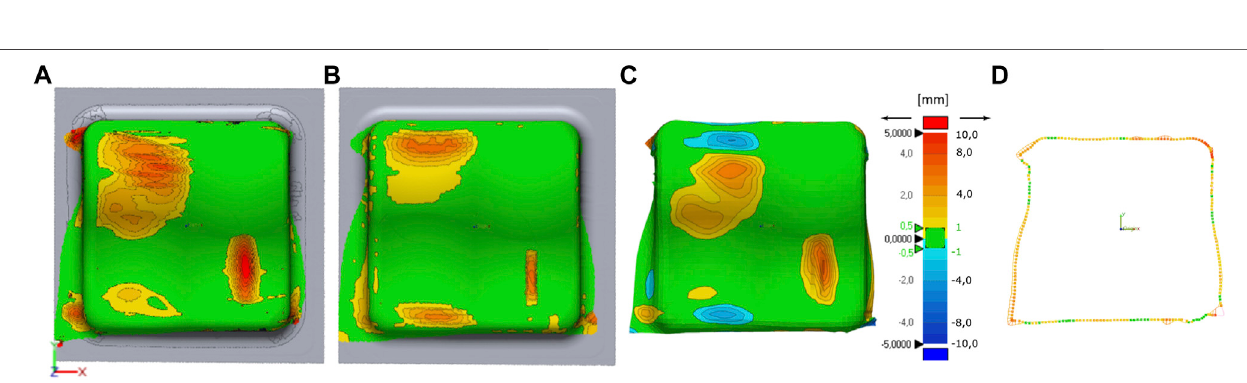
FIGURE 11 | 3D comparison of forming results from (A) the experiment against the tool, (B) the benchmark simulation against the tool, (C) direct comparison of experiment and benchmark simulation and (D) the deviation between the contour of the experiment and the benchmark simulation. The distance between the experiment and simulation is color coded, where green areas are±0.5 (1) mm, yellow to red areas are > + 0.5 (1) mm, and blue areas < − 0.5 (1) mm apart for (A – C) and (D) , respectively.